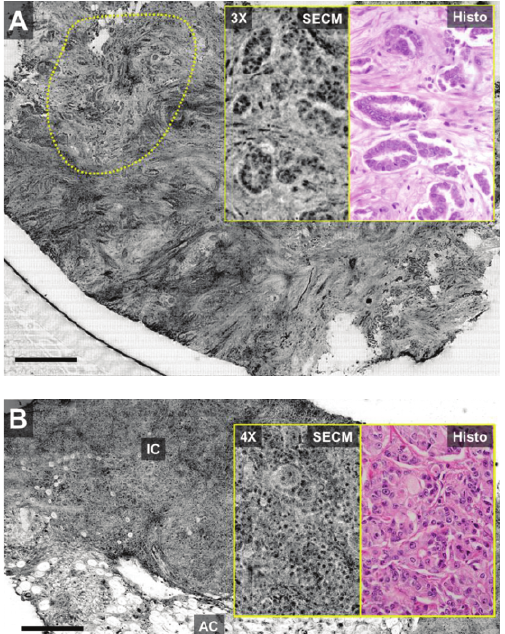
Figure 1: SECM images of low-grade invasive ductal carcinoma (A) and high-grade invasive carcinoma (B). Dotted region in (A) shows small glands invading the stroma in a disorganized fashion. IC— invasive carcinoma; AC—adipose cells. Scale bars = 0.5